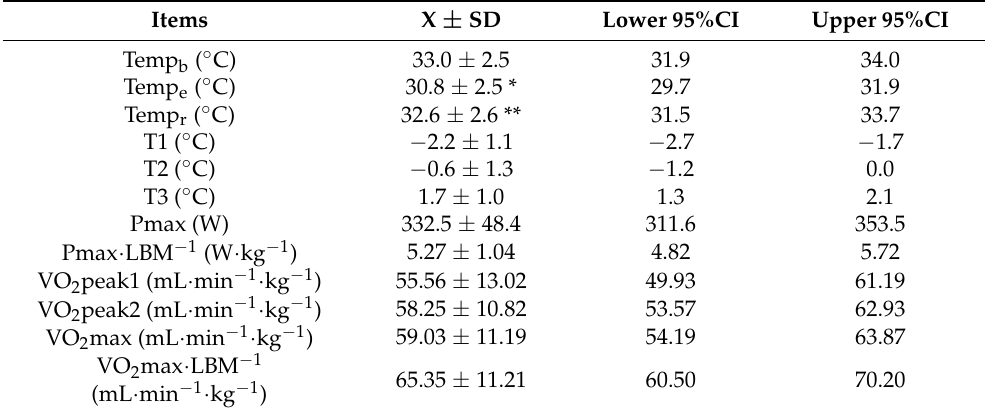
Table 2. Thermal parameters and baseline measurements of the physical capacity of the study participants.